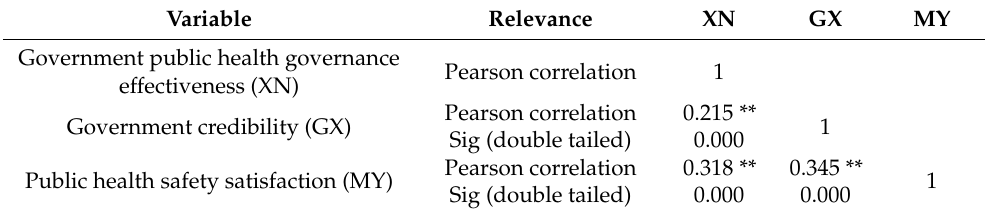
Table 11. Correlation analysis between variables.